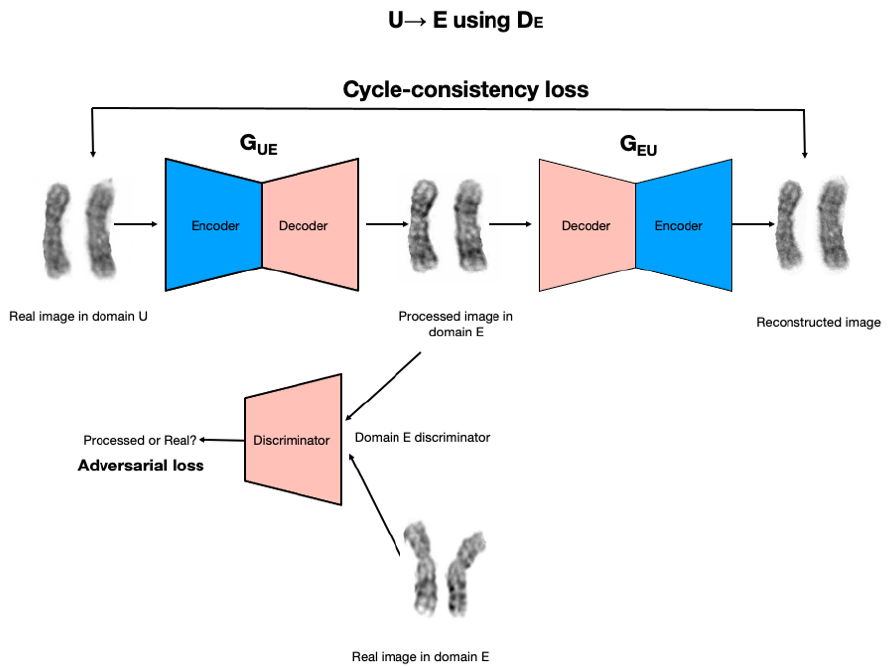
Figure 2. CycleGAN model architecture.